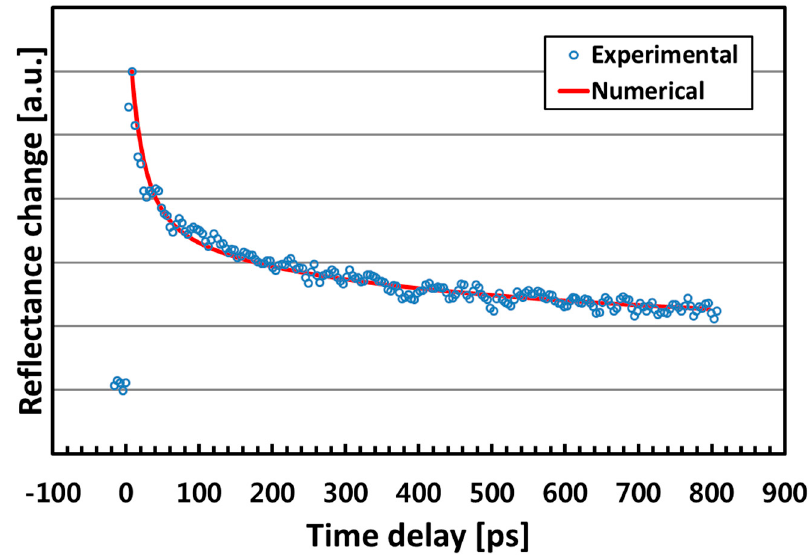
Figure 5. Thermoreflectance measurement data on the Al-coated YIG film. The curve fitting shows a thermal conductivity value of 11.0 W/m·K.